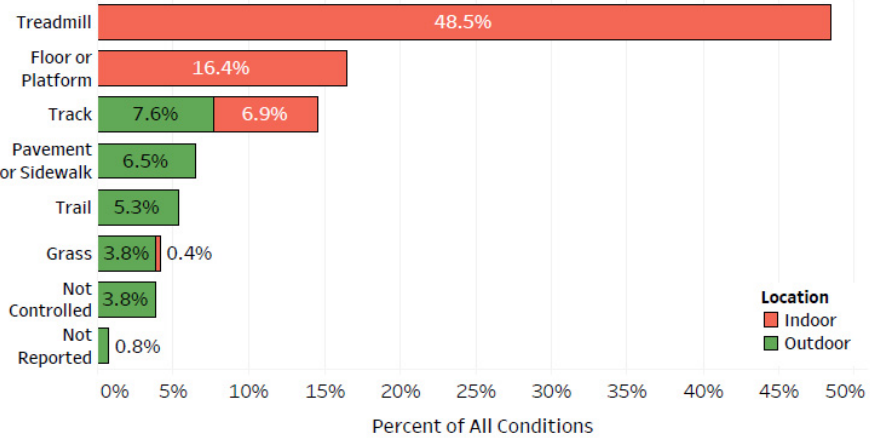
Figure 3. The percent of all conditions (262 across 231 studies) by running surface and location (indoor, outdoor).